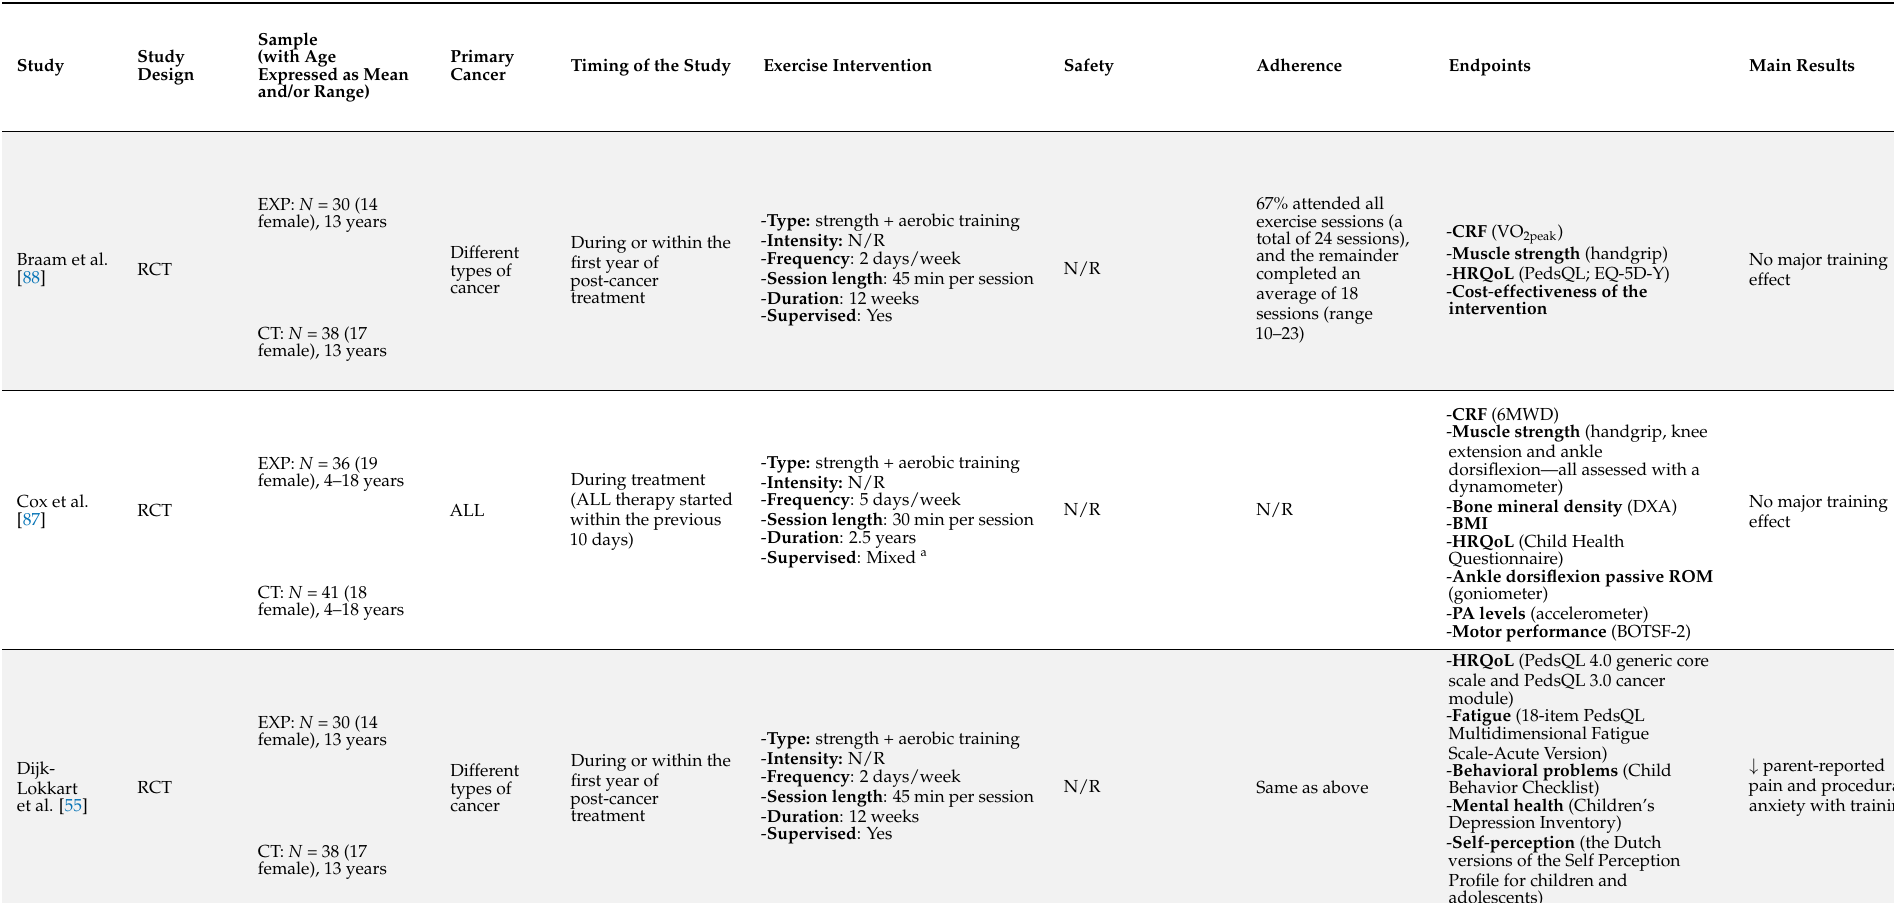
Table 1. Examples of relevant studies analyzing the effects of exercise intervention during childhood cancer